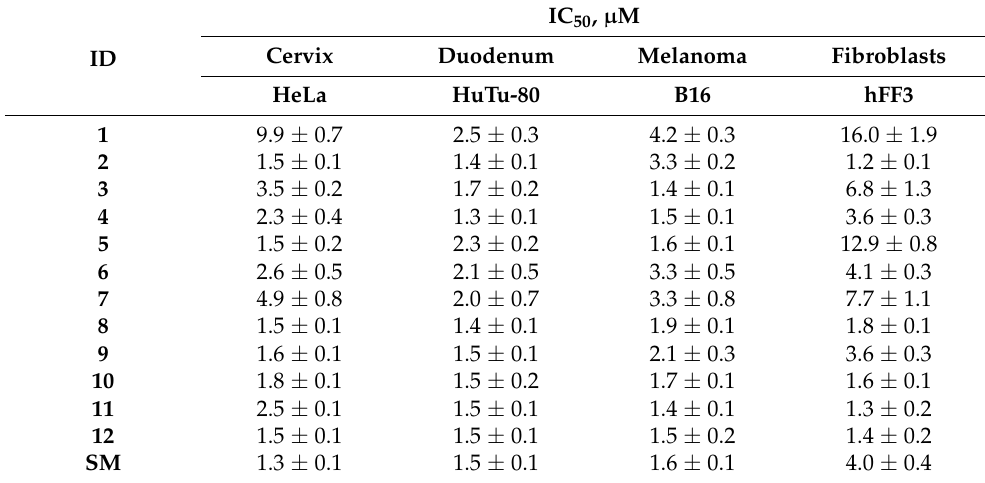
Table 1. Cytotoxicity of novel amide derivatives of